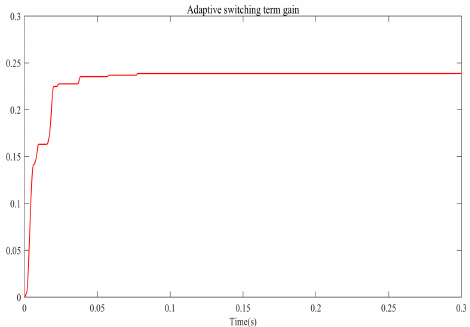
Figure 10. Adaptive curve of switching term gain of ASMC in APF.